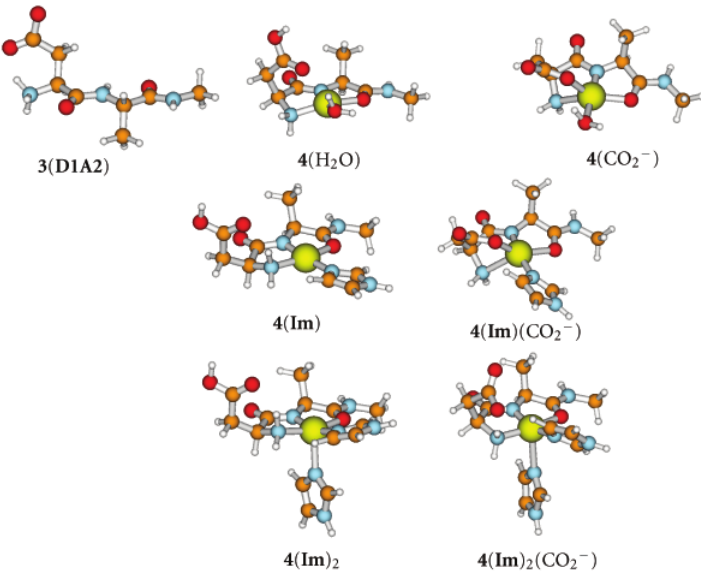
Figure 2: Structures with Cu(II), Asp1Ala2 3 , and imidazole Im . Ball colors: Cu: large yellow; C: orange; N: blue; O: red; H: